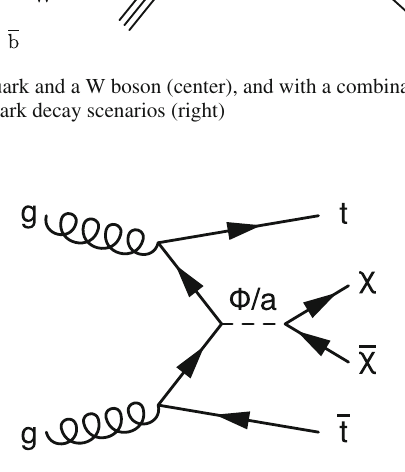
Fig. 2 Feynman diagram of direct DM production through a scalar ( φ ) or pseudoscalar (a) mediator particle, in association with a top quark pair